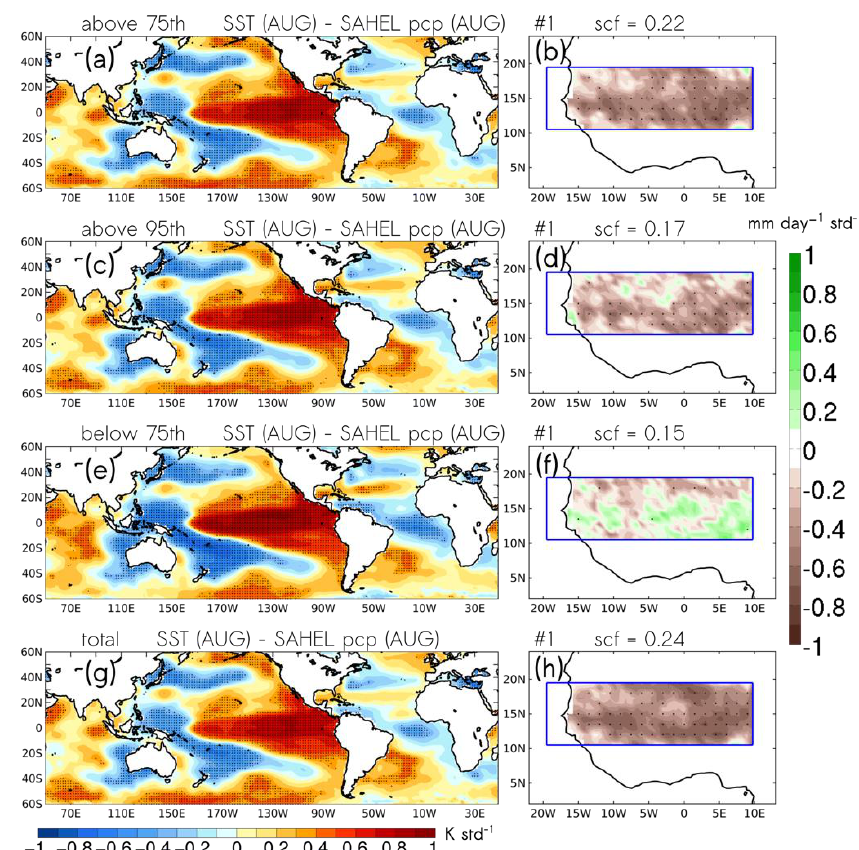
Figure 1. Co-variability maps corresponding to the leading maximum covariance analysis (MCA) mode calculated between global SST anomalies (SSTA; 60 ◦ S–60 ◦ N) and di ff erent percentiles of anomalous Sahel (20 ◦ W–20 ◦ E; 10 ◦ –20 ◦ N) rainfall from the Chirps data set. ( Left column ) Homogeneous SSTA (K std − 1 ) maps obtained by regression of sea surface temperature (SST) expansion coe ffi cient U (see Figure S1) onto global SSTA. ( Right Column ) Heterogeneous maps of anomalous rainfall (mm day − 1 std − 1 ) obtained by regression of SST expansion coe ffi cient U onto regional anomalous Sahelian rainfall. Co-variability maps are depicted for precipitation ( a , b ) above the 75th percentile, ( c , d ) above the 95th percentile, ( e , f ) below the 75th percentile and ( g , h ) total precipitation. The squared covariance fraction (scf) for each case is shown in figure titles. Stippling denotes 95% (0.05) statistical significance under a Monte Carlo test (1000